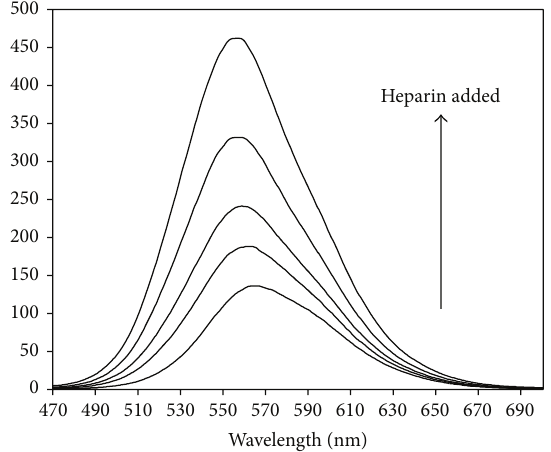
Figure 3: Luminescence spectra of [Os(bpy) 2 CO(4-phpy)](PF 6 ) 2 in ethanol solution (2.8mg/100mL) in the presence of varing concen- trations of heparin. From bottom to top, heparin concentration: 0, 9.9, 19.6, 29.1, and 38.5 𝜇 g/mL.